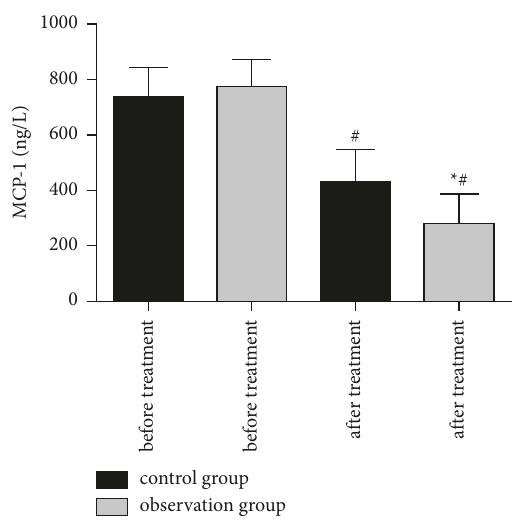
Figure 4: Macular volumes of two groups of patients at different times. Compared with the same group before treatment, # P < 0 . 05; compared with the control group, ∗ P < 0 . 05.